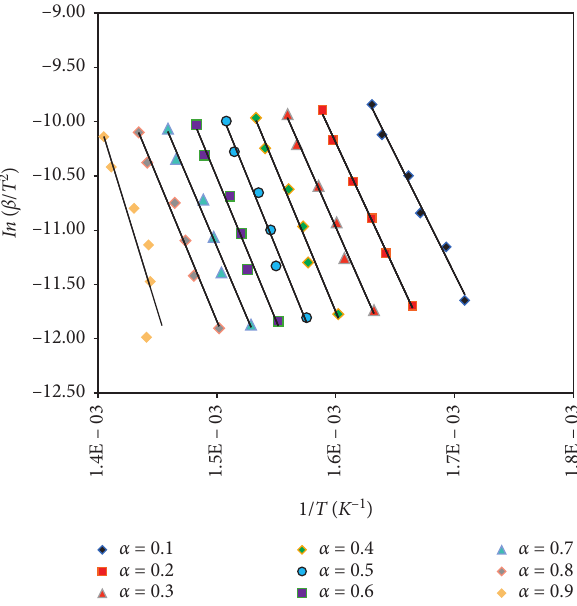
Figure 8: KAS plots ln ( β / T 2 ) versus 1/ Τ for sample PNVP- co - PHMA 80–20.